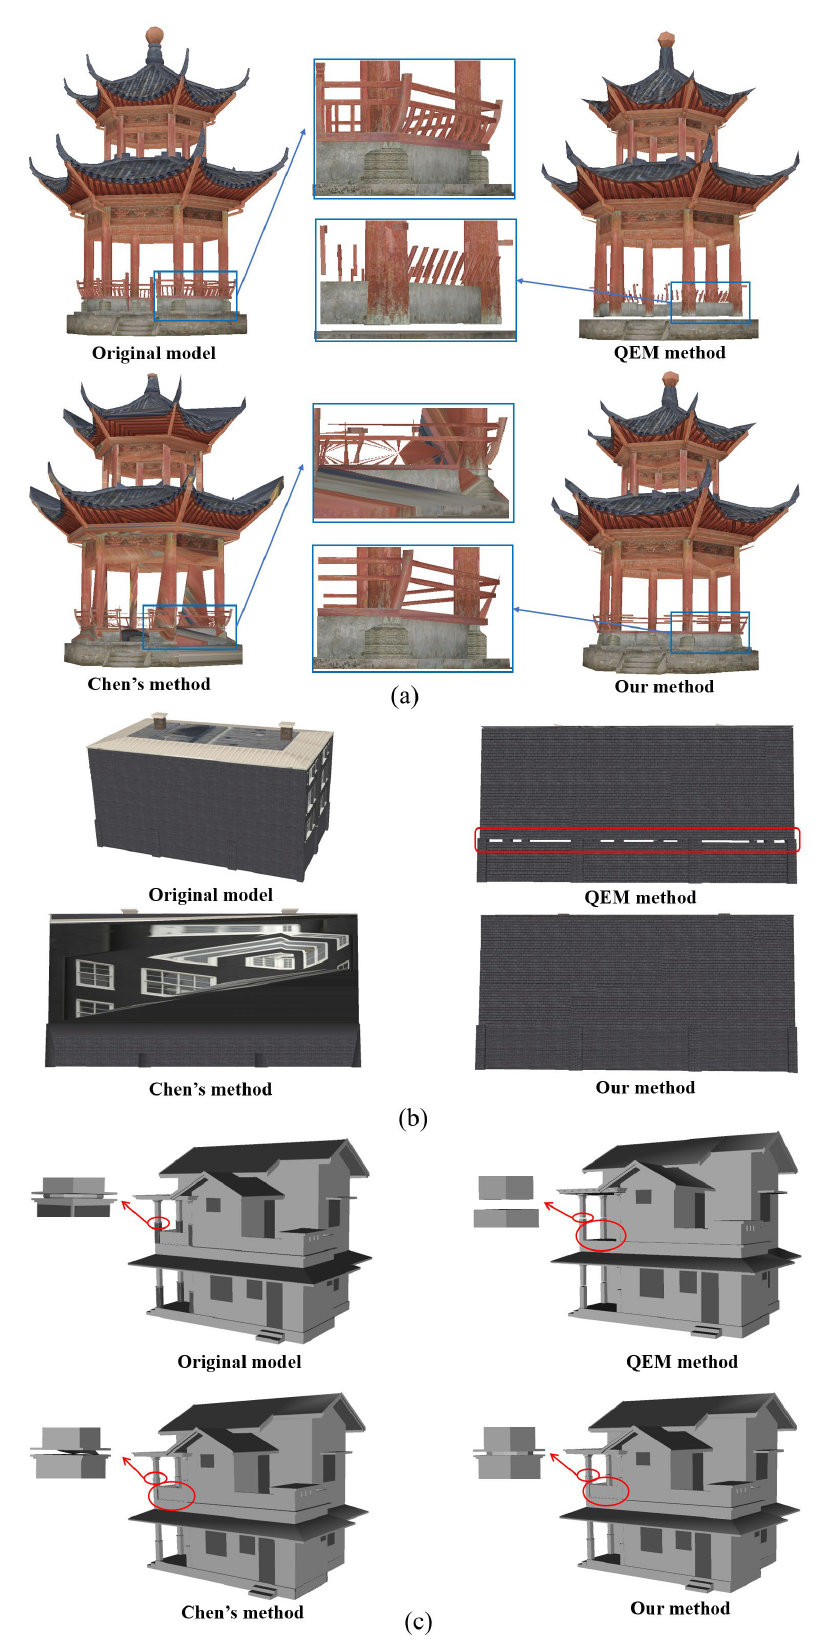
Figure 14. Comparison of simplification results for the three building models: ( a ) the pavilion; ( b ) the apartment; ( c ) the house.